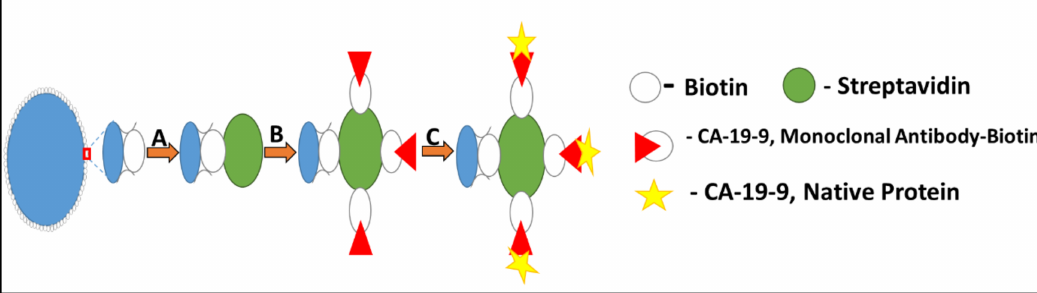
19-9 Schematic representation of the sample preparation (Biotinylated